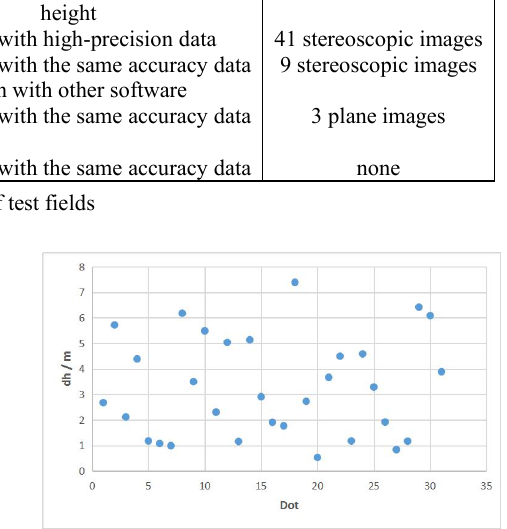
Figure 4. Errors of elevation accuracy in field 1